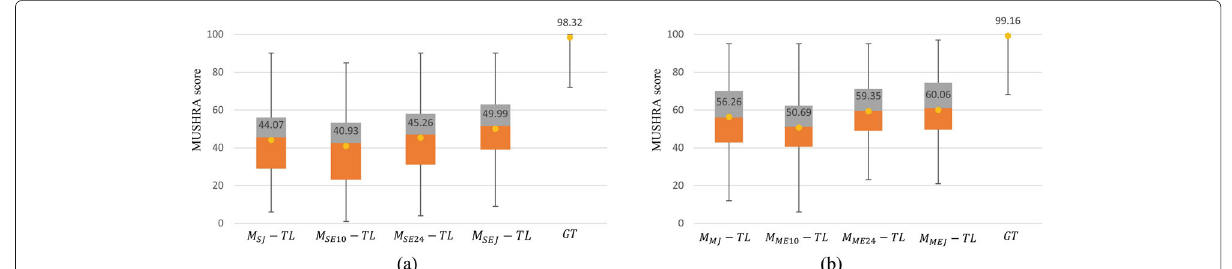
Fig. 5 MUSHRA naturalness scores for single-speaker and multi-speaker models trained using cross-lingual transfer learning, where ( a ) are single-speaker models trained with one high-resource language or both and ( b ) are multi-speaker models trained with one high-resource language or both. M SJ ( Japanese ) , M SE10 ( English,10hours ) , M SE24 ( English,24hours ) , M SEJ ( EnglishandJapanese ) : sequentially trained single-speaker models. M MJ ( Japanese ) , M ME10 ( English,10hours ) , M ME24 ( English,24hours ) , M MEJ ( EnglishandJapanese ) : simultaneously trained multi-speaker